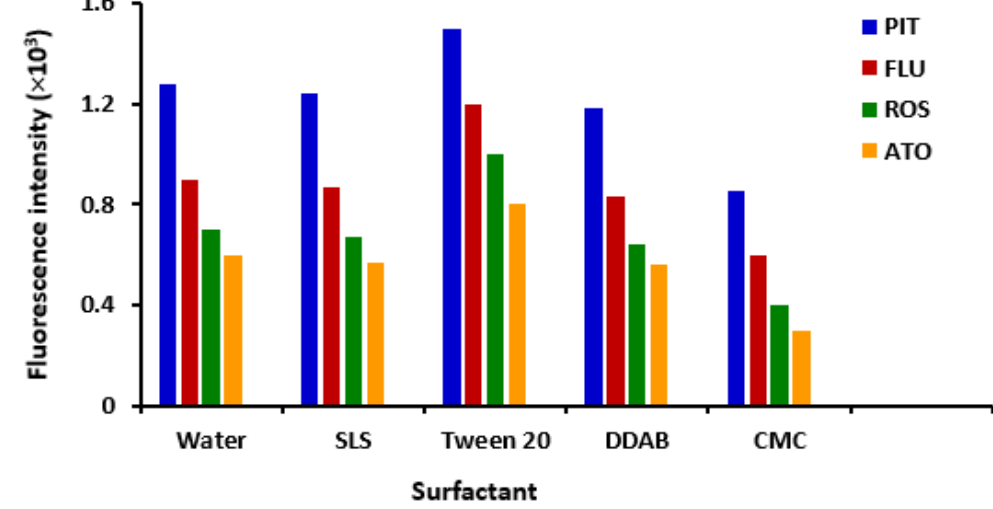
Figure 4. Effect of type of surfactant on the fluorescence intensity of statin solution (200 ng mL –1 ) compared with an aqueous solution without any surfactant. Concentrations were 1, 2, 5 and 50 µ g mL − 1 for PIT, FLU, ROS and ATO, respectively. Values are the mean of 3 determinations. The abbreviations (SDS, DDAB and CMC) denote sodium lauryl sulfate, dodecyl dimethyl ammonium bromide and carboxymethyl cellulose, respectively.